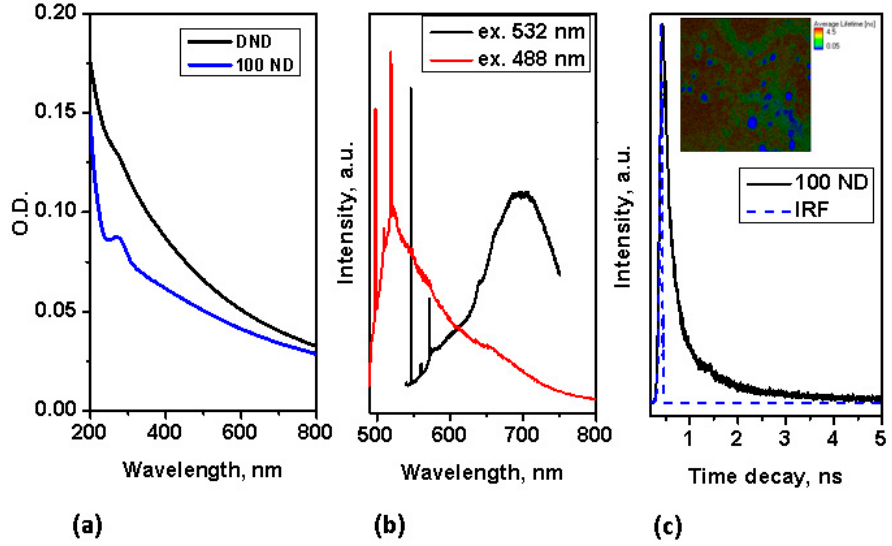
Figure 2. Characterization of spectroscopic properties of NDs: ( a ) absorption spectra of NDs; ( b ) Fluorescence spectra of 100 ND at excitations of 532 nm and 488 nm; ( c ) time decay of 100 ND fluorescence measured at two-photon femtosecond excitation (with a pulse laser at 800 nm); inset-FLIM of 100 ND particles positioned on an Si substrate.